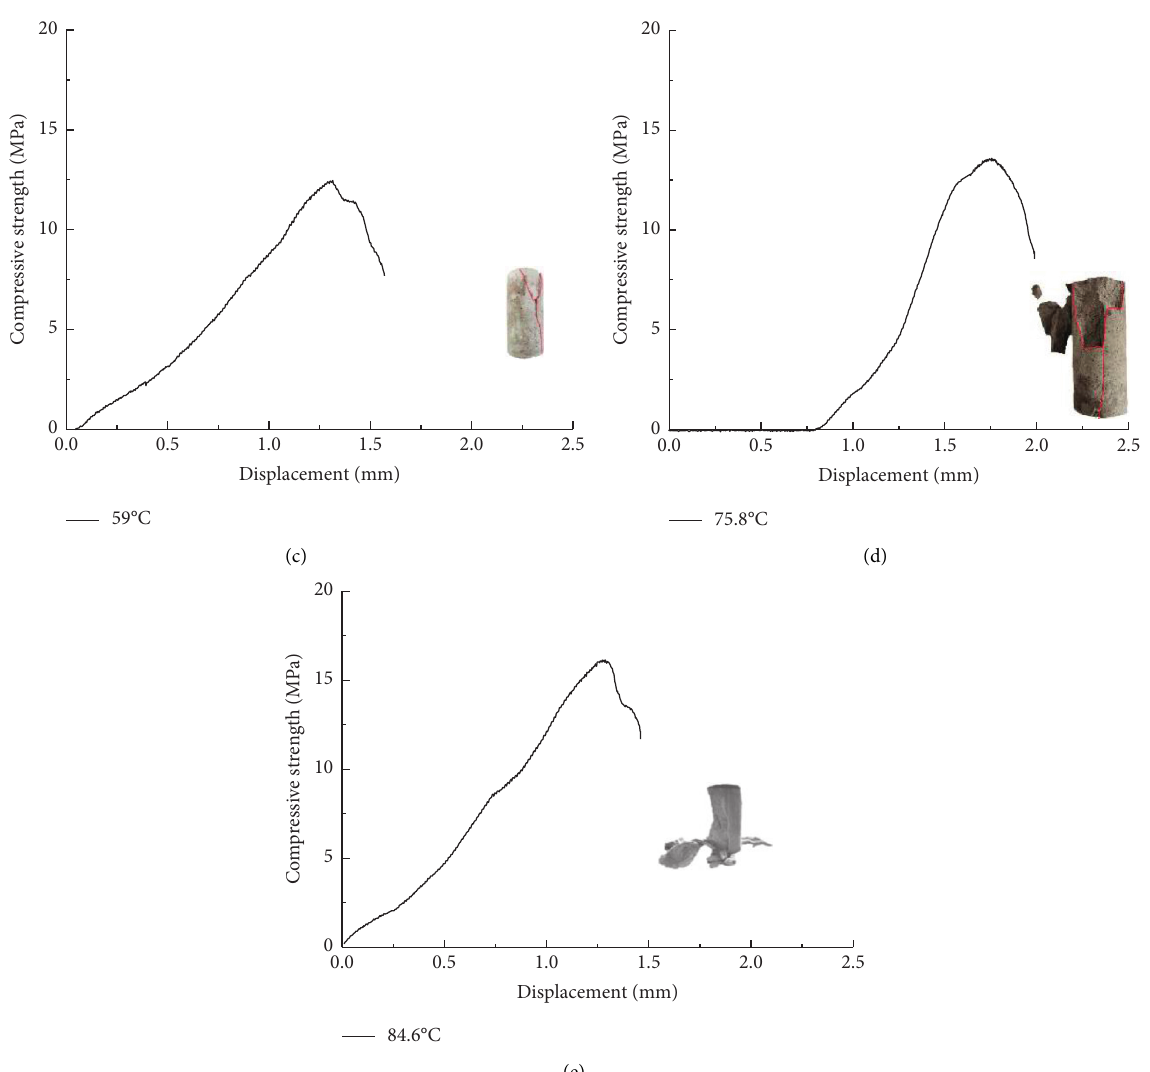
Figure 13: Uniaxial compressive strength curves of the rockburst similar materials at different temperatures covered by the